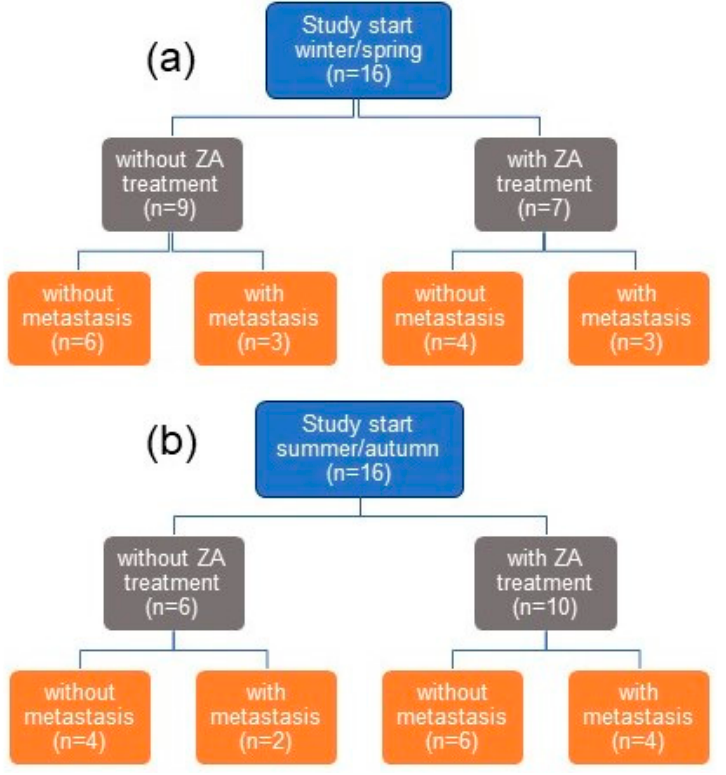
Figure 1. Overview of the study design and patient characteristics depending on the season of the study’s start in winter/spring ( a ) and summer/autumn ( b ). Abbreviation: ZA = zoledronic acid.